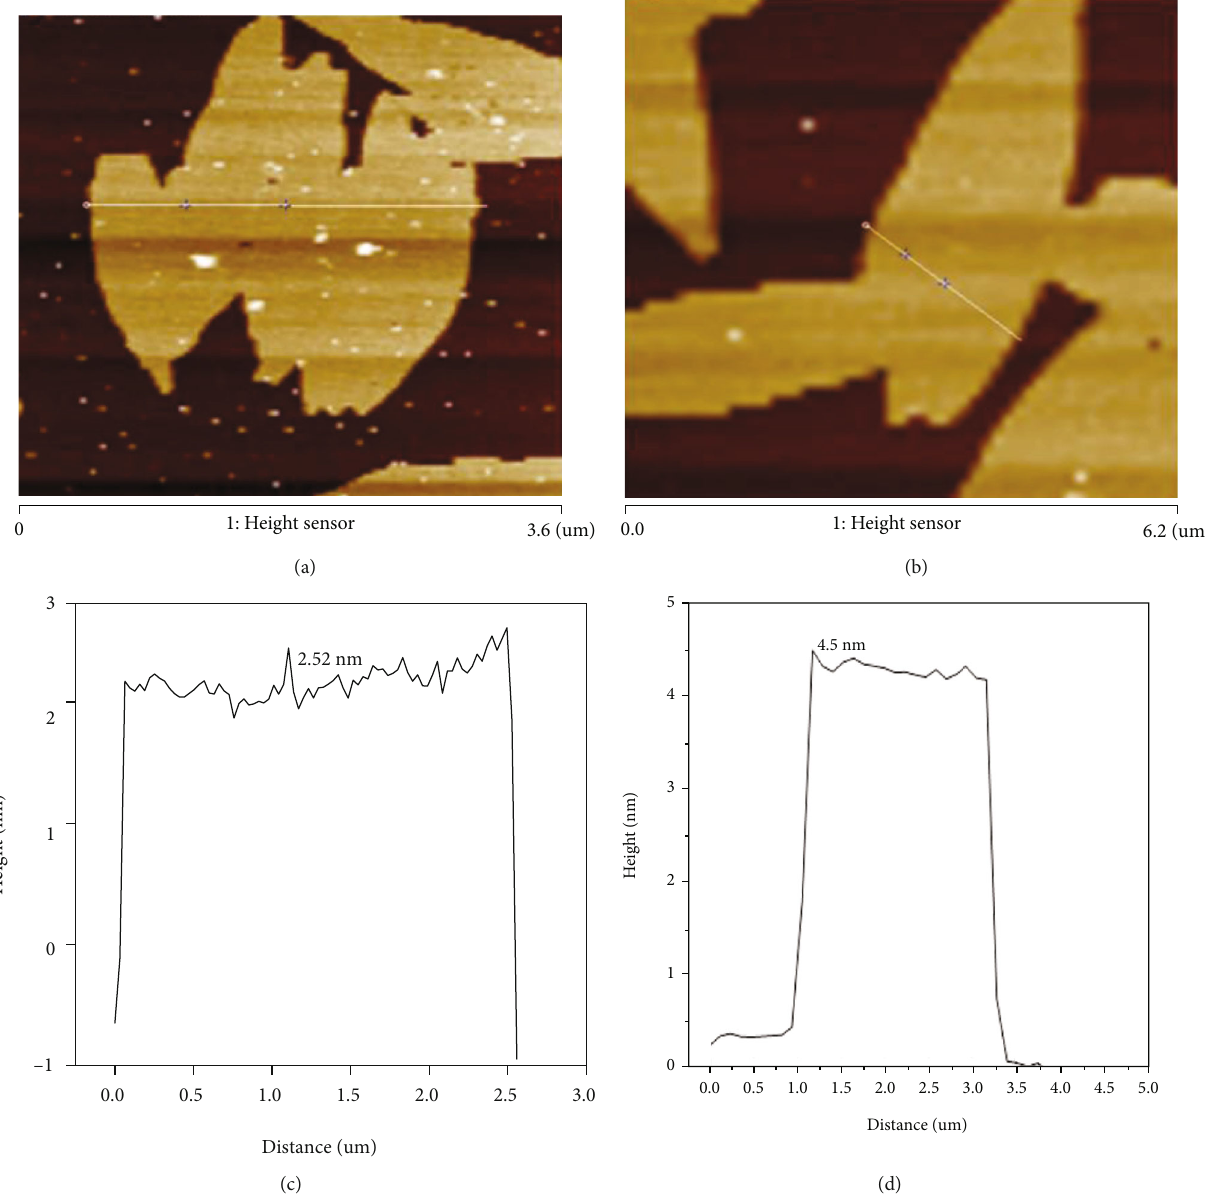
Figure 6: (a) GO AFM; (b) GO/red sandstone AFM; (c) GO height map; (d) GO/red sandstone height